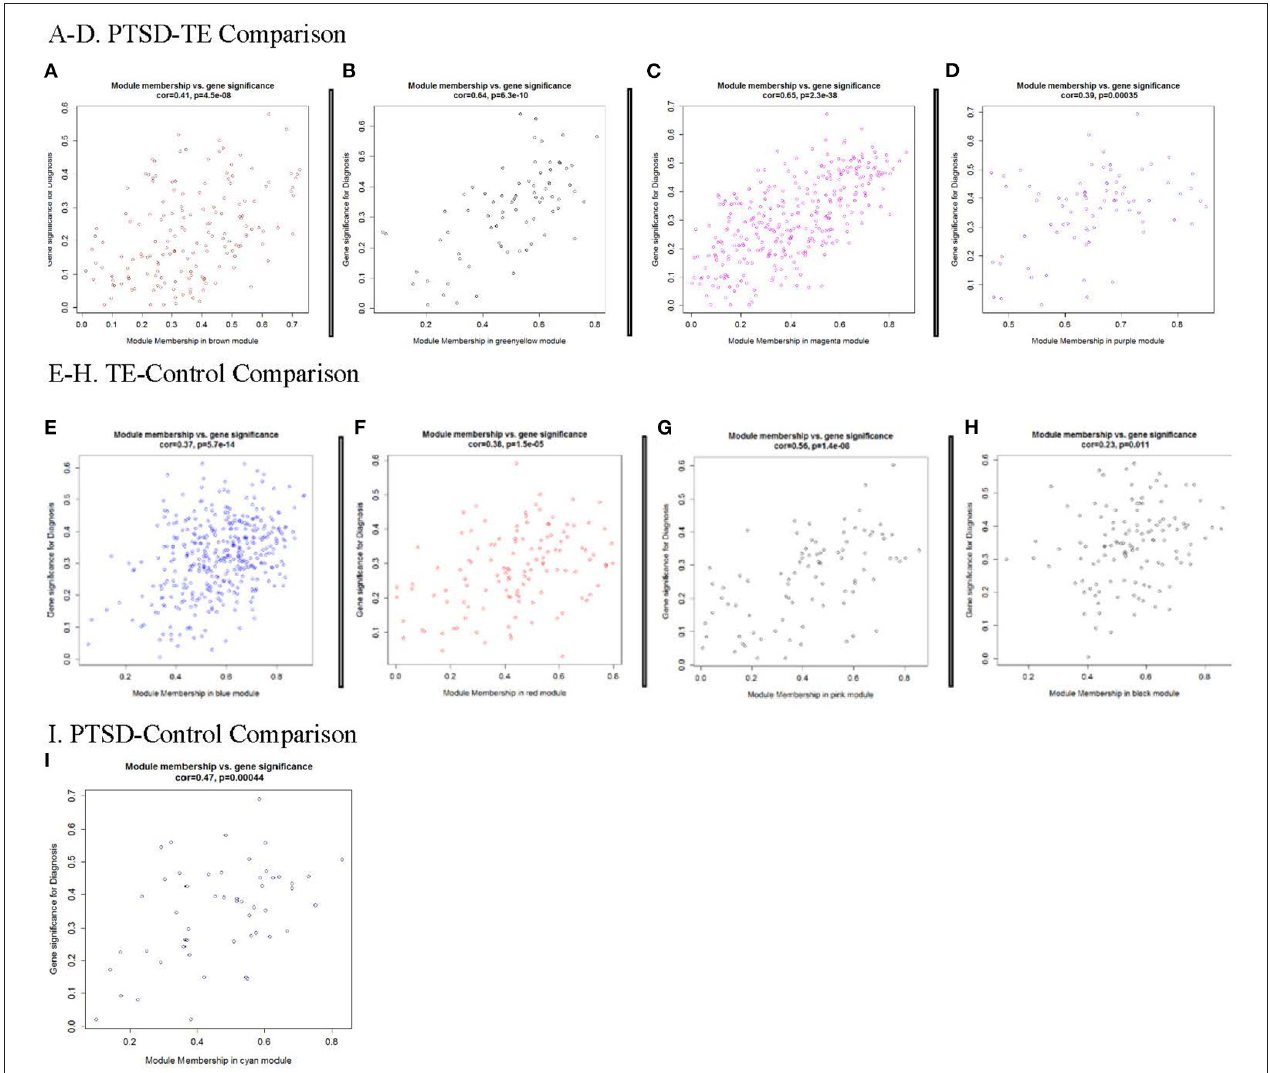
FIGURE 2 | Modules significantly correlated with Diagnosis. Each point represents an individual transcript within each module, which are plotted by the absolute value of their expression correlation to Diagnosis [Gene Significance (GS)] on the y-axis and module eigengene [Module Membership (MM)] on the x-axis. The correlation and corresponding p -values are shown for each plot, indicating that increases of GS for transcripts is reflected by the concomitant increase in intramodular connectivity (MM). (A–D) Modules significantly correlated with PTSD/TE; (E-H) Modules significantly correlated with TE/Cont; and (I) Module significantly correlated with